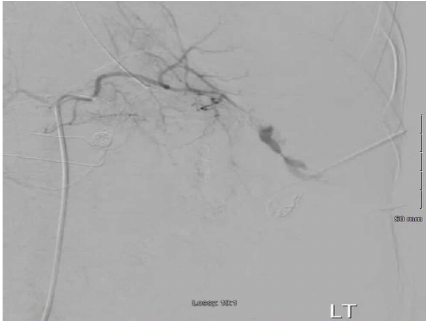
Figure 1: Angiogram of the spleen, showing distal splenic artery contrast extravasation.